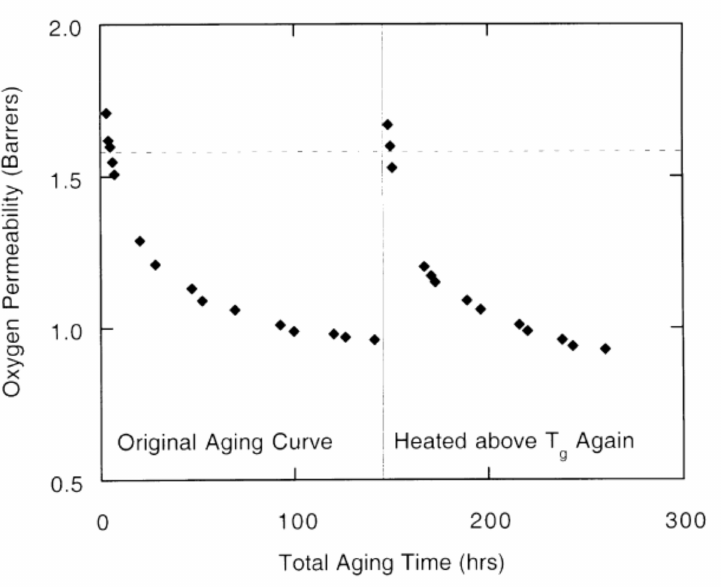
Figure 20. Demonstration of the reversal of the ageing effects on O 2 permeability coefficients by heating above T g again. The vertical line marks the time when the membrane was re-heated above T g (used with copyright permission)